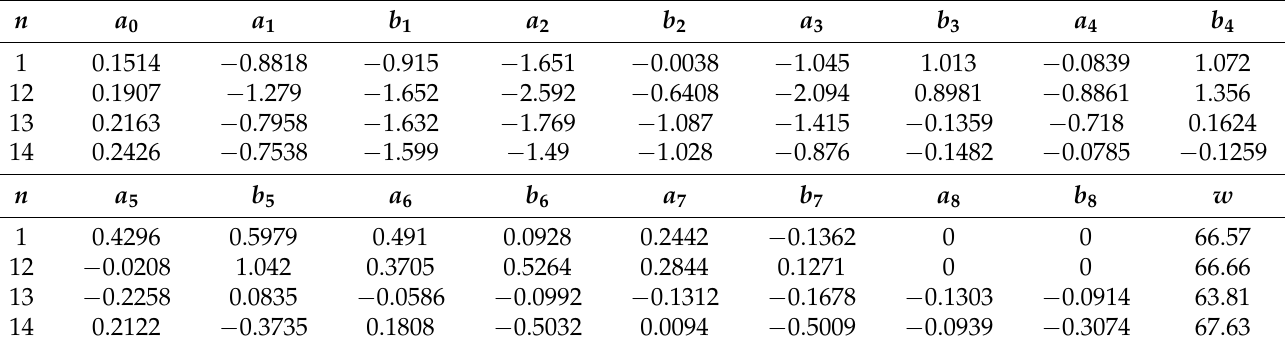
Figure 6. Electromechanical coupling function and residuals for different configurations of the modular coil: active segment 1 ( a ), active segment 12 ( b ), active segment 13 ( c ) and active segment 14 ( d ). Table 2. Coefficients of the Fourier EC